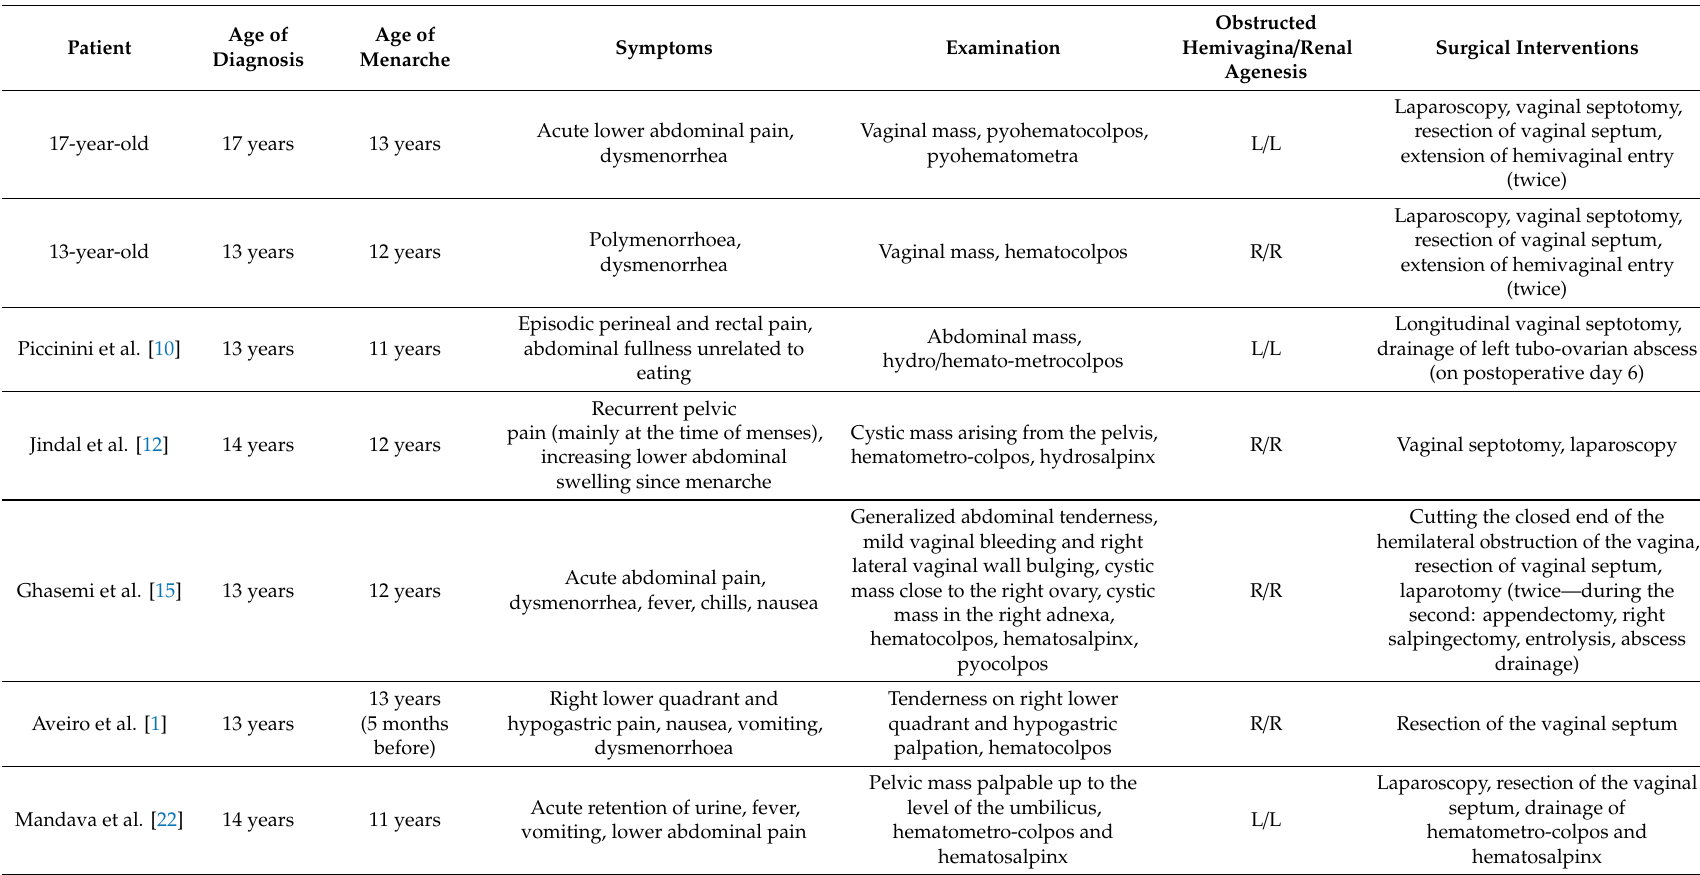
Table 1. Comparison of the described patients with selected cases from the literature. L—left,